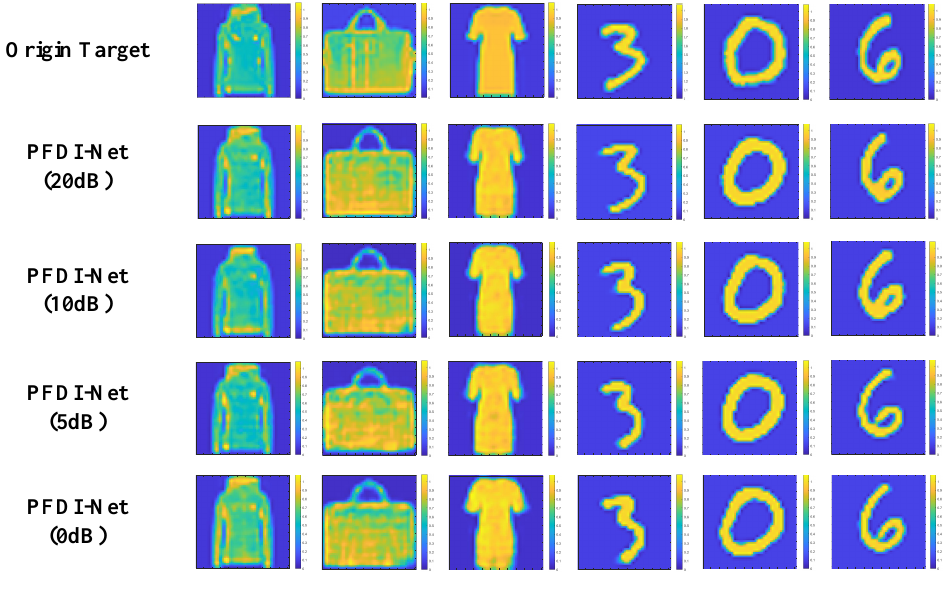
Figure 9. Reconstruction results from PFDI-Net with different SNR.